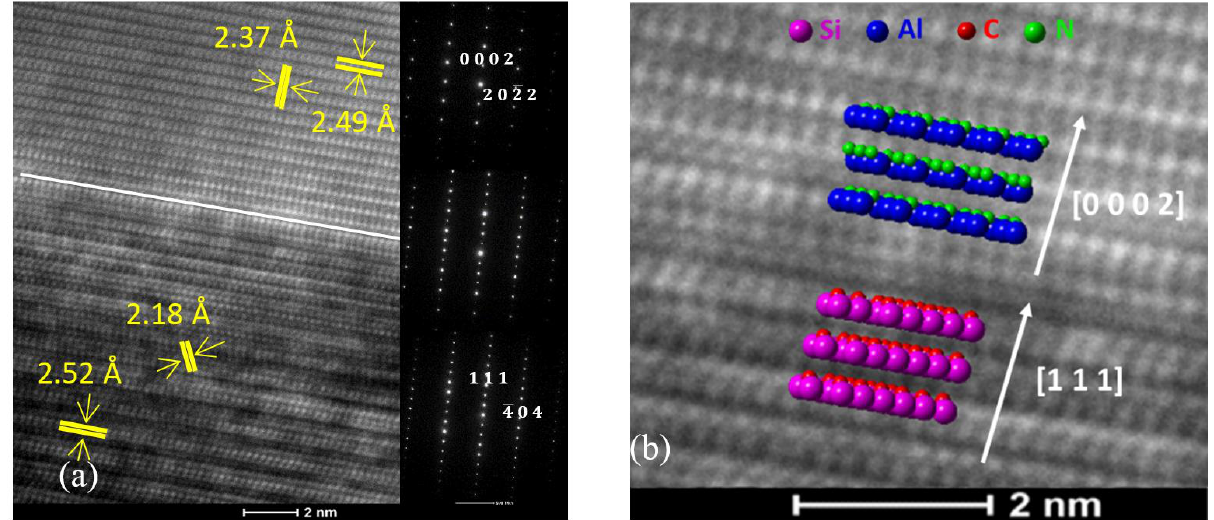
Figure 1. ( a ) HR-TEM micrographs and SAED patterns depicting the atom planes in SiC and AlN with respect to their interface; ( b ) HR-TEM micrographs overlaid with simulated crystal lattices near the interface between the SiC substrate and the AlN buffer